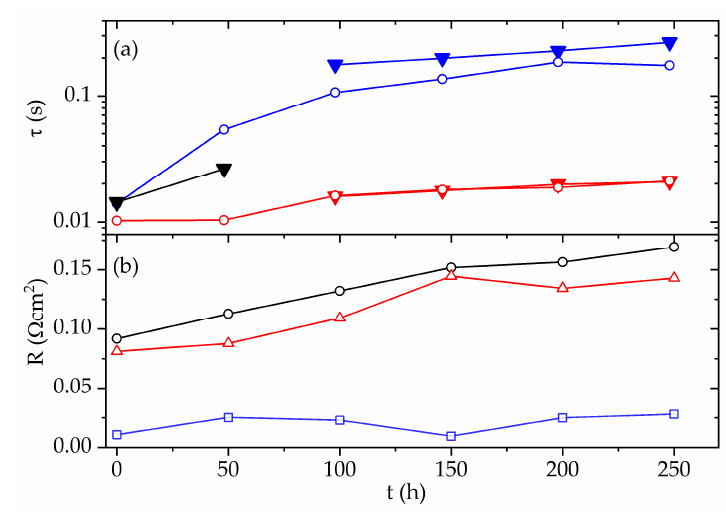
Figure 7. Relaxation times as calculated by DRT (full symbols) and EqC (open symbols) ( a ) and total polarization (black), Ri (red), and Rs (blue) resistances ( b ) at different aging times. T = 700 °C. Discontinuity of DRT in ( a ) is motivated by time constant closer than one order of magnitude for t < 100 h.